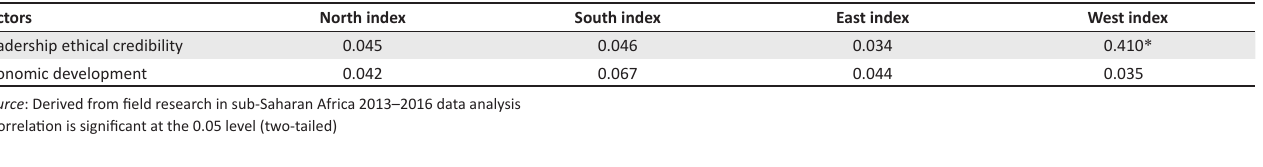
TABLE 4: Promote human rights, transparency and accountability towards the citizens. Profile of respondents